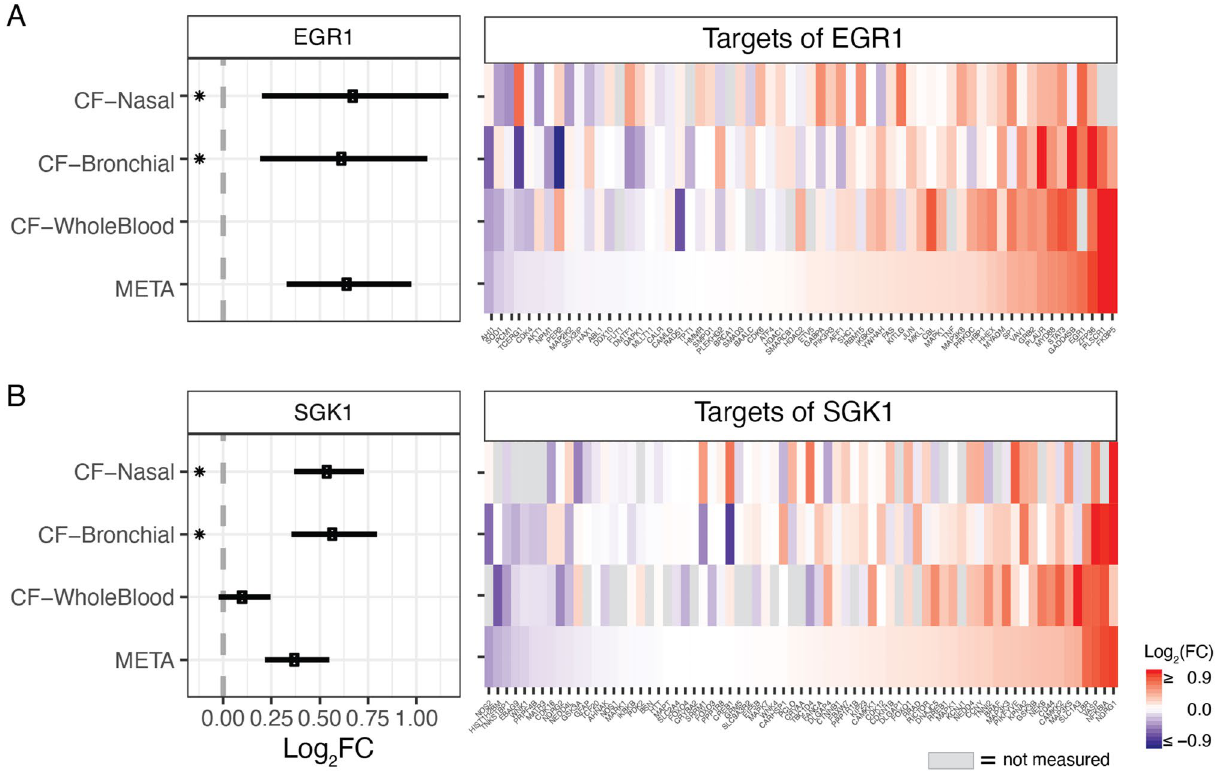
Figure 3. Differential expression of EGR1 , SGK1 and their downstream targets in CF vs. non-CF comparisons. ( A ) Left: Forest plot showing differential expression of EGR1 transcript. Right: Differential expression